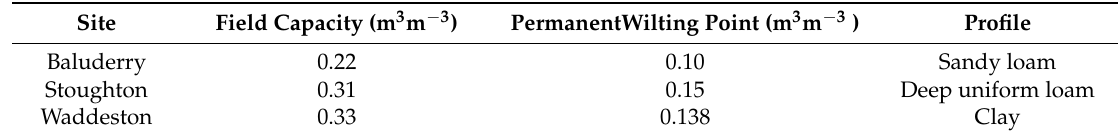
Table 3. Soil characteristics of the model development sites applied in the AQUACROP